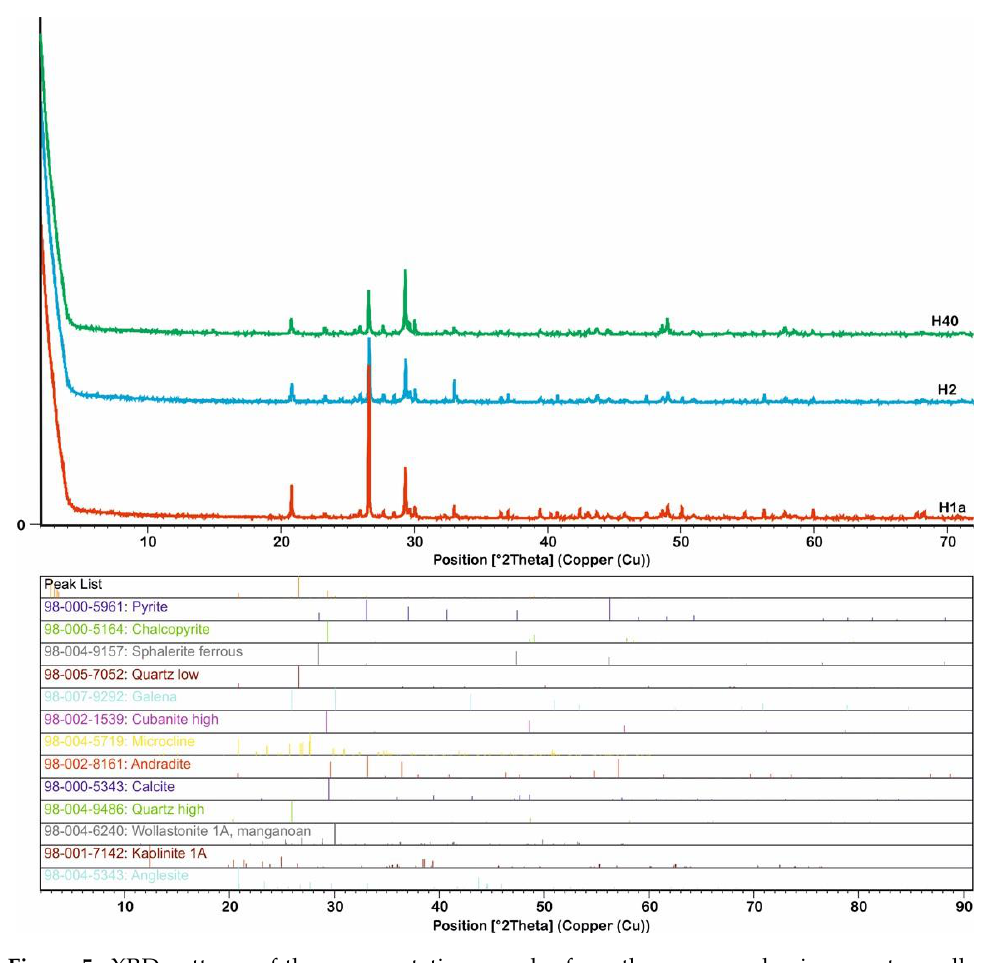
Figure 5. XRD patterns of the representative samples from the ore zone, having quartz; wollastonite; kaolinite; microcline; calcite; chalcopyrite; andradite; anglesite; and cubanite with pyrite, sphalerite, galena.